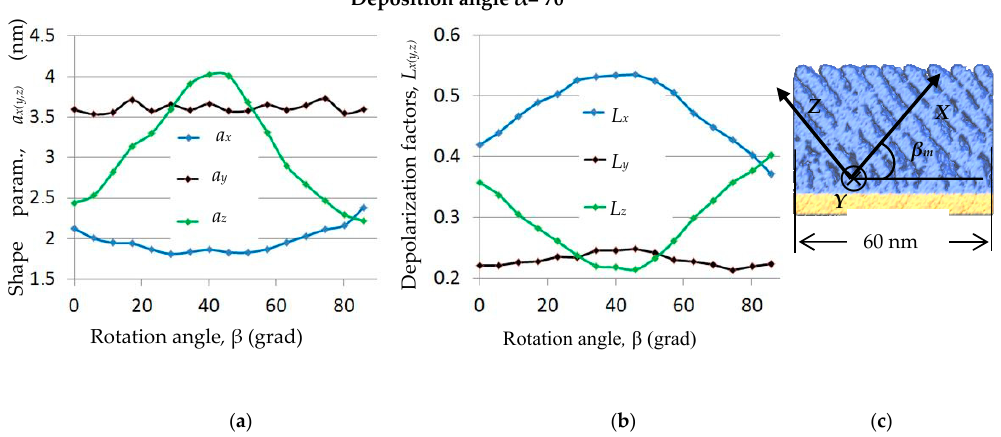
Figure 7. Dependencies of the shape parameters and depolarization factors on the rotation angle β , β m is the rotation angle at which the maximum value of L x – L z is reached . ( a ) Values of shape parameters; ( b ) Values of the depolarization factors; ( c ) Orientation of the coordinate axes The results of the refractive index calculation are shown in Figure 8 and in Table 2 and are The dependencies of the depolarization factors on the angle β are explained in the same way. compared with experimental data known from the literature. For α = 50° the ∆ n value is less than 0.003, i.e., is at the level of anisotropy of the normally deposited SiO 2 films [32]. The dependences of the refractive index on the rotation angle β for the deposition angles α = 60°, 70°, 80° are similar. The difference ∆ n = n z – n x reaches its maximum at a certain value of the rotation angle β = β m . The value of β m increases with increasing of α . This is explained by an increase of the tilt angle of the separated columns in GLAD films with the increase in the deposition angle [3]. Since the pores are elongated along these columns, the angle between the substrate plane and Z semi-axis of the ellipsoids also increases.